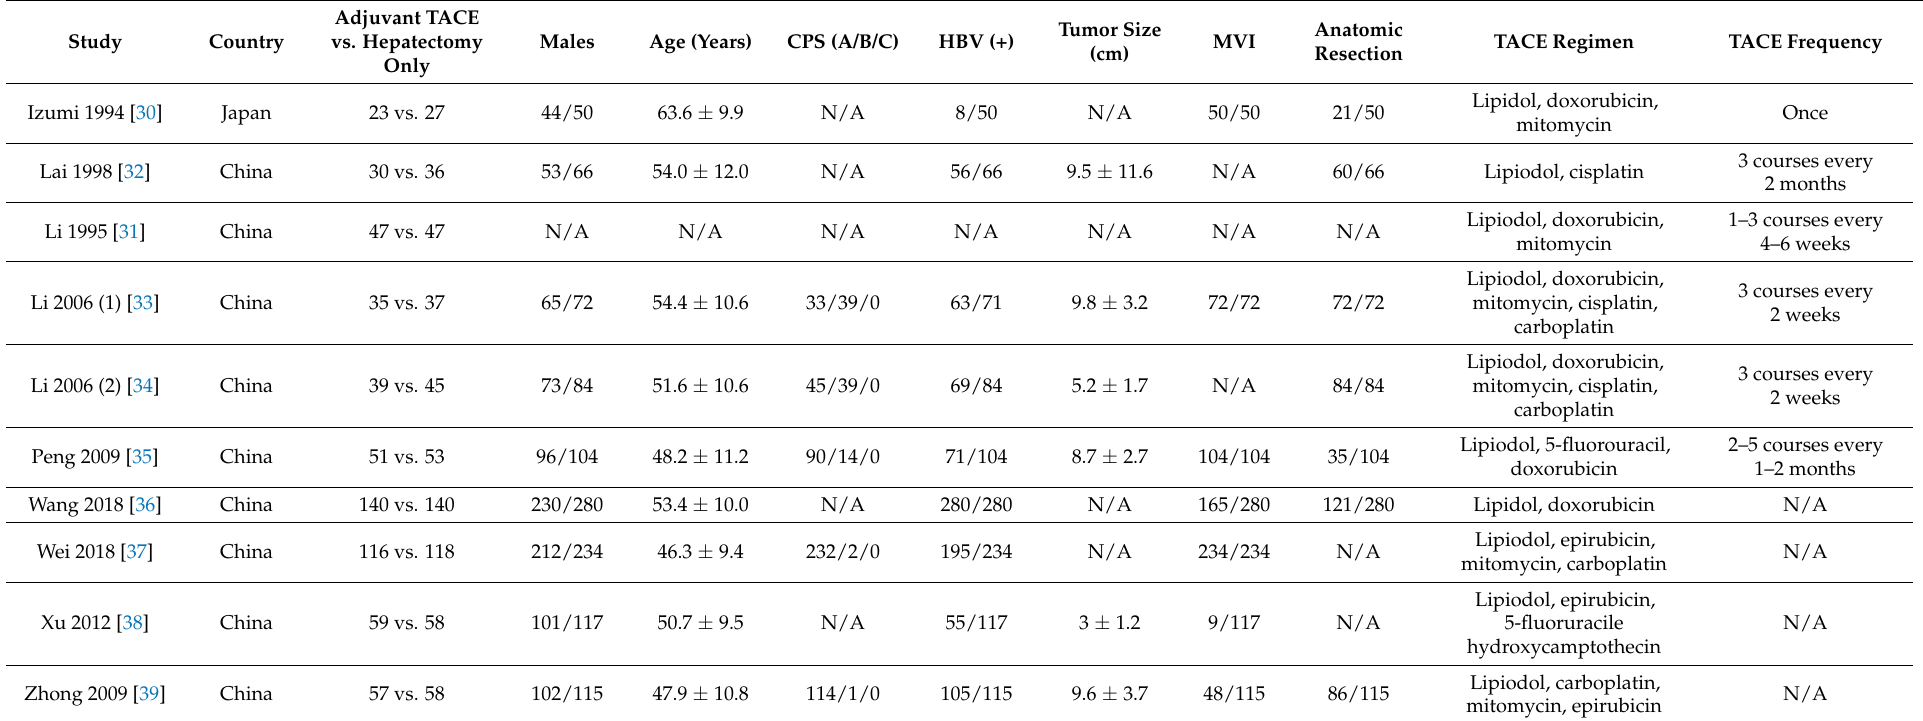
Table 1. Characteristics of the included